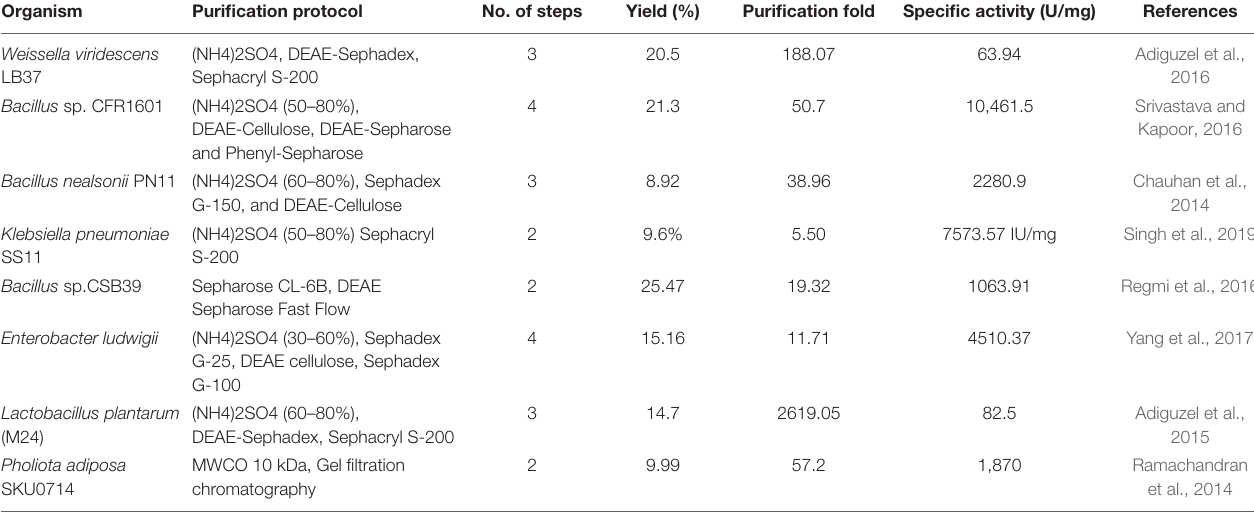
TABLE 3 | Protocols used to purify β -mannanases from various